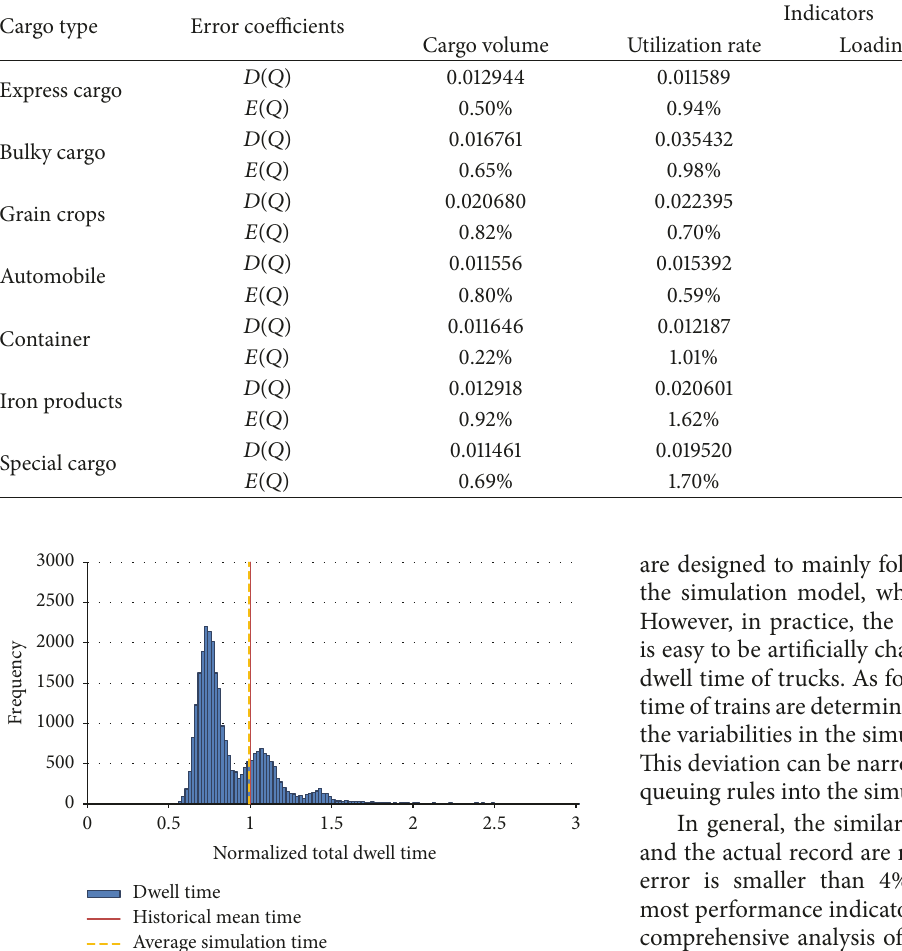
Table 1: Simulation error coefficient results.